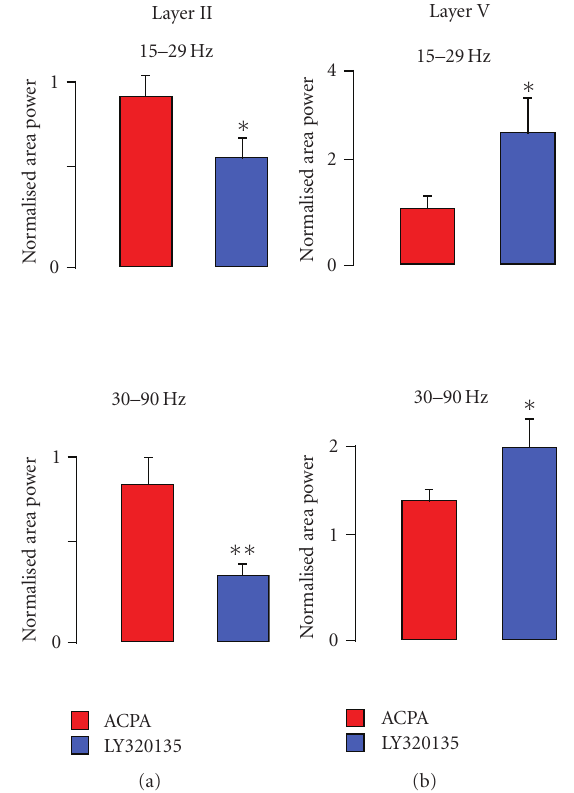
Figure 5: Summary of the e ff ects of cannabinoid ligands on oscillatory activity in mEC. (a) Bar charts showing the e ff ects of cannabinoid ligands in layer II on normalised area power at γ and β frequencies. (b) Bar charts showing the e ff ects of inverse agonists alone in layer V on normalised area power at γ and β